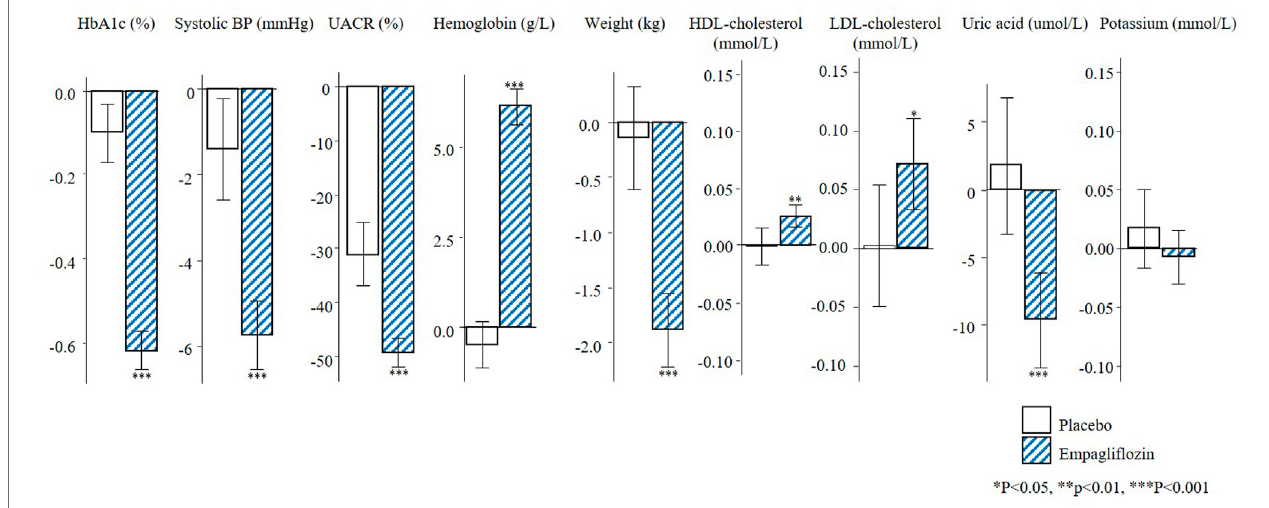
FIGURE 2 | Mean changes in risk markers from baseline to 6-months in the population with UACR ≥ 30 mg/g of the EMPA-REG OUTCOME trial (N (cid:1) 2811). Changes are presented as mean with 95% con fi dence intervals, for the placebo and empagli fl ozin group. HbA1c, glycated hemoglobin; BP, blood pressure; UACR, urinary-albumin-creatinine-ratio; HDL, high-density-lipoprotein; LDL, low-density-lipoprotein.